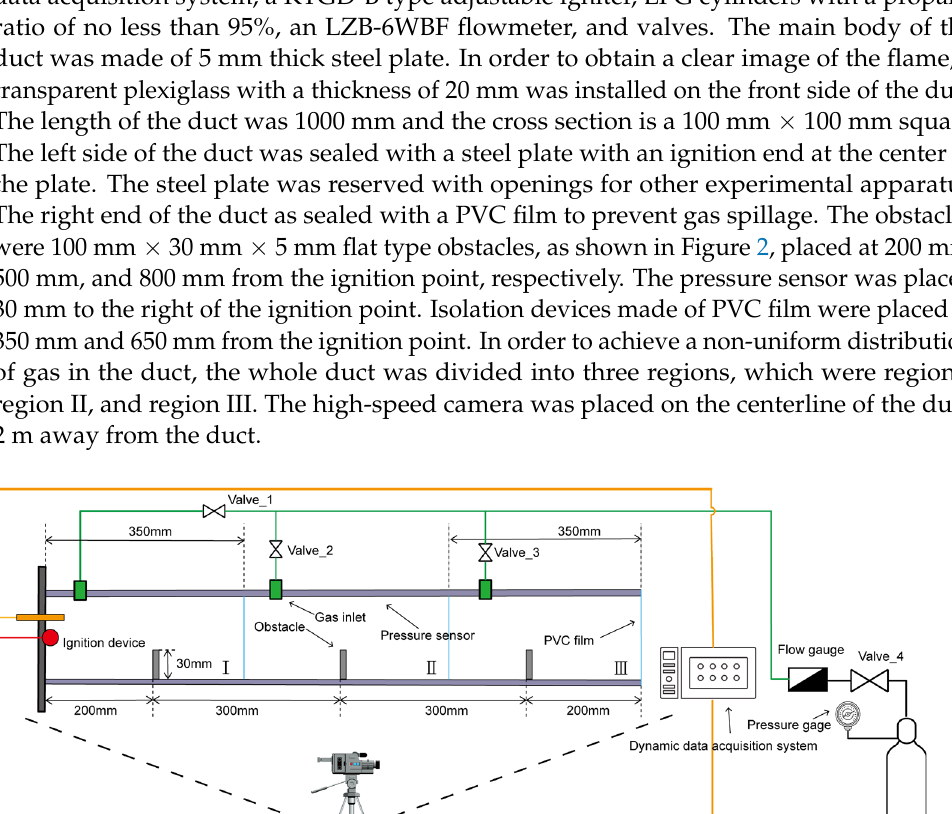
Figure 2. Obstacle. 2.2. Experimental Methods After the duct, obstacles, data acquisition equipment, and other equipment were in- stalled, the high-speed camera, pressure sensor, and data acquisition system were turned on and left in standby mode. Then, the LPG cylinder with a propane percentage of no less than 95% and Valve_4 were opened. After waiting for the gas to fill the hose, Valve_1 was turned on. The flow meter was then observed, and the flow meter was 0.3 L/min. The flow was controlled through the flow meter, and Valve_1 was closed after 41 s of filling in Area I. Afterwards, area II was inflated for 29 s and area III was inflated for 28 s by the same method. The equivalent ratios of the three regions were 1.5, 1.2, and 1, respectively. After the end of the filling, the igniter and high-speed camera synchronously were turned on, controlled by the computer, and the ignition energy was 20 J. To ensure the validity of the experimental data, the explosion experiment repeated at least three groups. 3. Numerical Model In this paper, numerical simulations are performed using the LES model and pre- mixed combustion model, which are mostly described in the relevant literature [39,40] and the combustion model can be obtained in the Ref. [27]. Filtered by Favre, only the large-scale turbulence is solved and calculated by coupling mass conservation, momen- tum conservation, energy conservation, and species conservation equations to the consti- tutive and state equations to obtain the LES control equations, which are not repeated in this paper. The component transport equation is reconstructed to obtain the transport